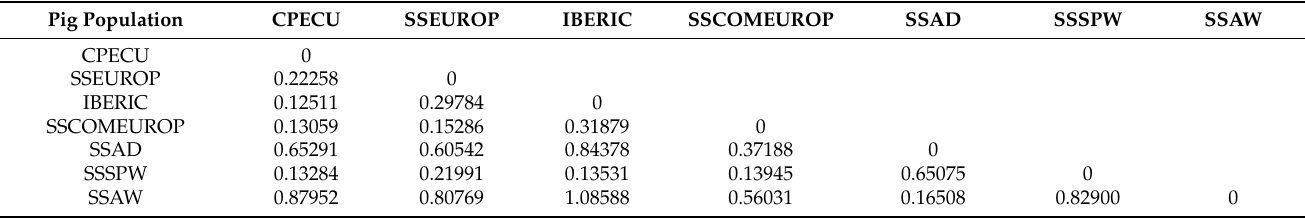
Table 4. Coancestry coefficient indices for each population studied.